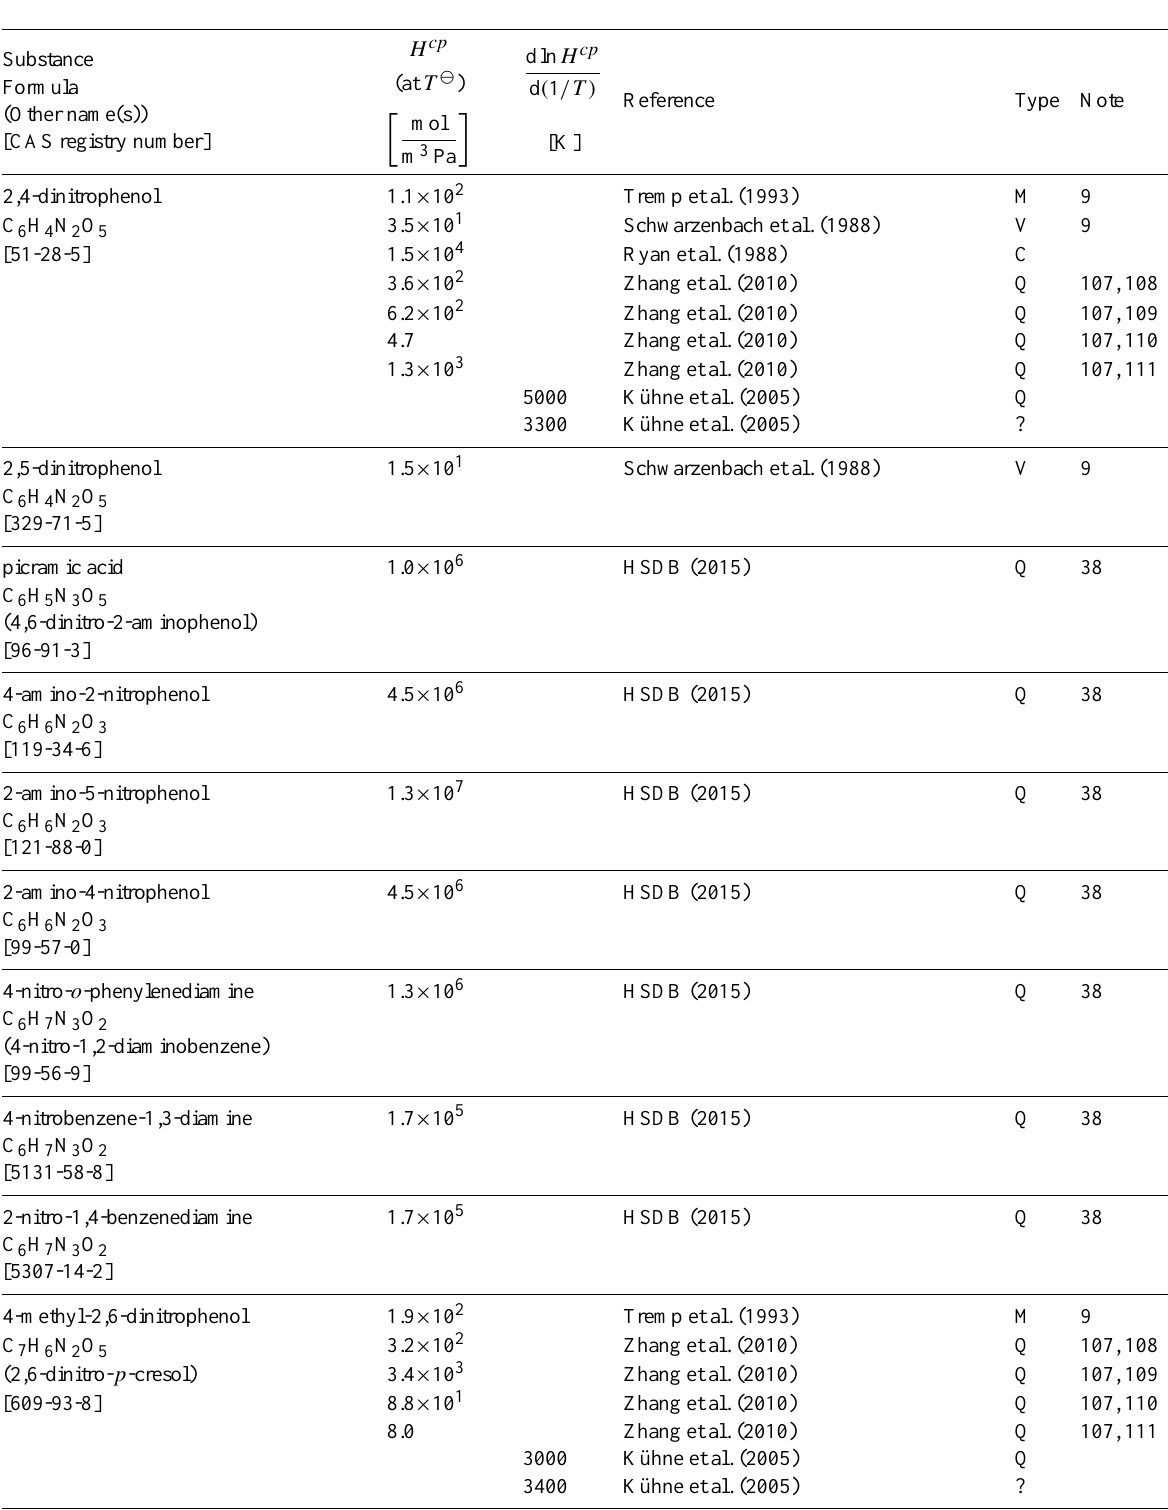
Table 6: Henry’s law constants for water as solvent